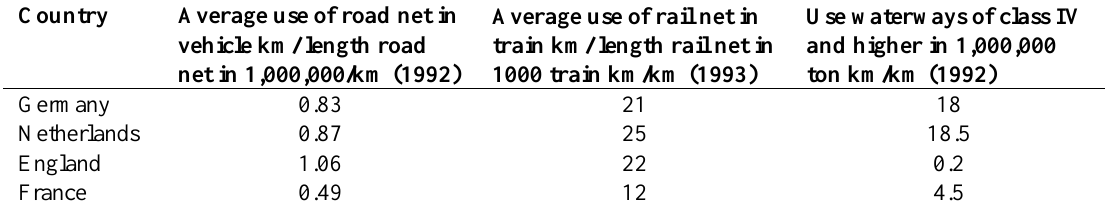
Table 9. Saturation of infrastructure Country Average use of road net in Average use of rail net in Use waterways of class IV vehicle km/ length road train km/ length rail net in and higher in 1,000,000 net in 1,000,000/km (1992) 1000 train km/km (1993) ton km/km (1992) Germany 0.83 21 18 Netherlands 0.87 25 18.5 England 1.06 22 0.2 France 0.49 12